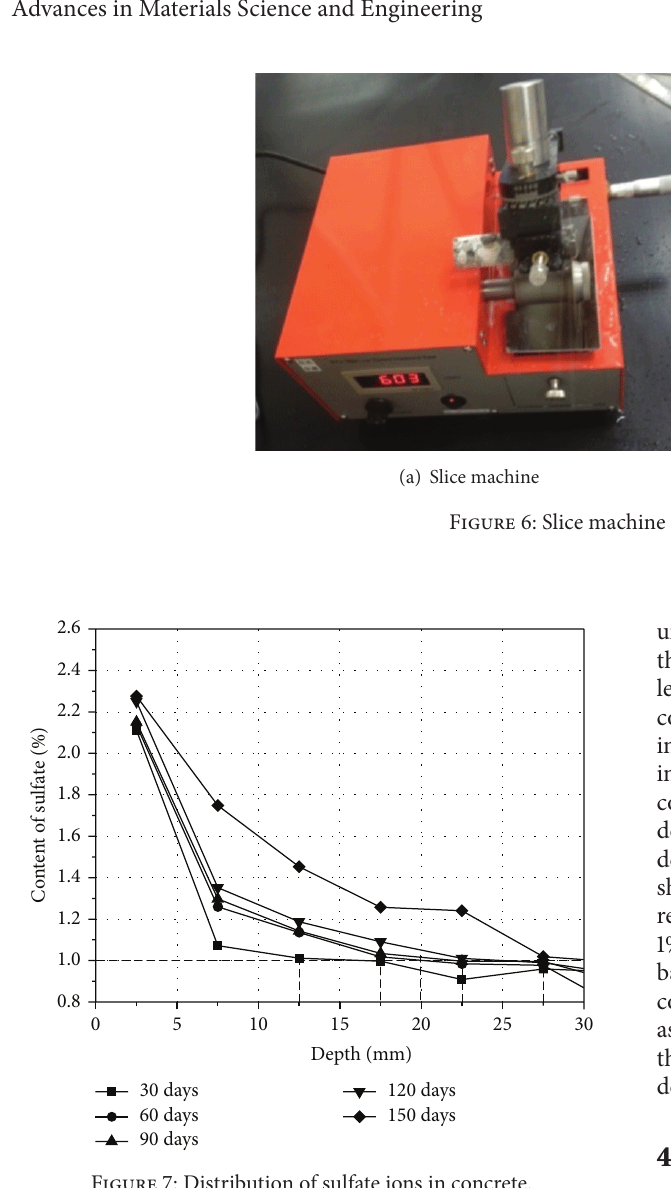
Figure 7: Distribution of sulfate ions in